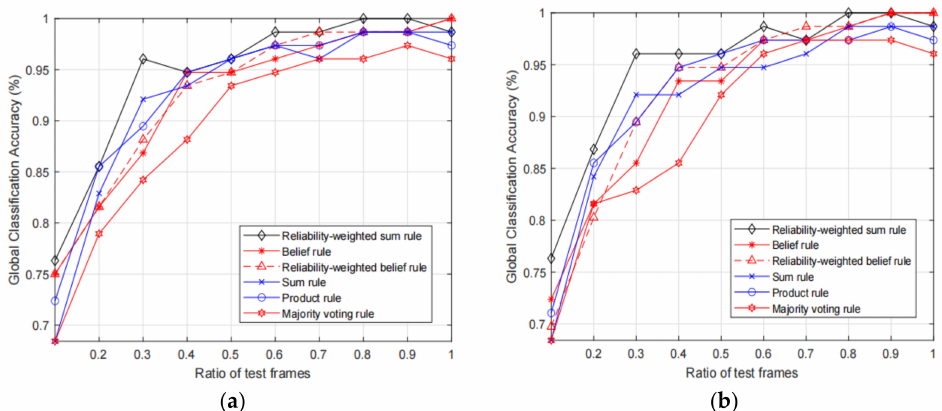
Figure 5. Comparison of fusion accuracies with 6 optical motion trackers, in which ( a ) and ( b ) show the results with original input features and calibrated input features,